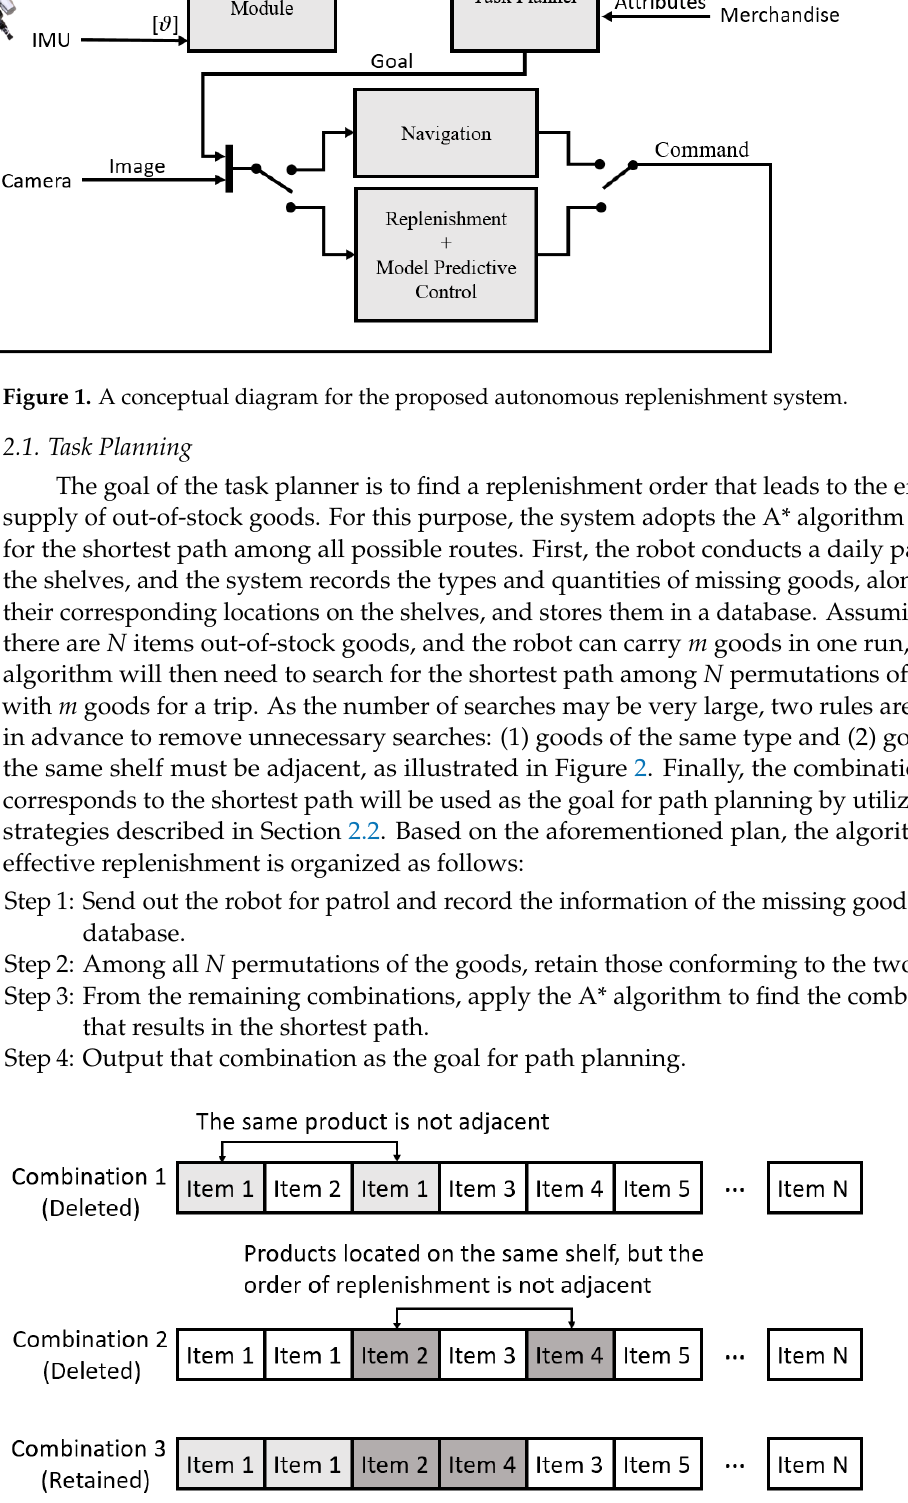
Figure 2. Locating combinations that meet the